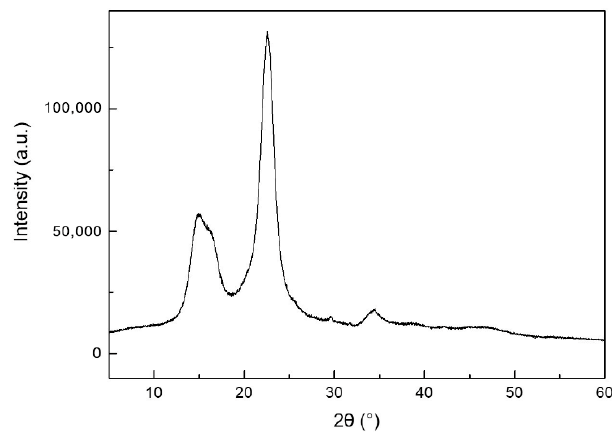
Figure 4. XRD of graphene materials and CNC/GM sol mixtures containing 2 wt % of GM.